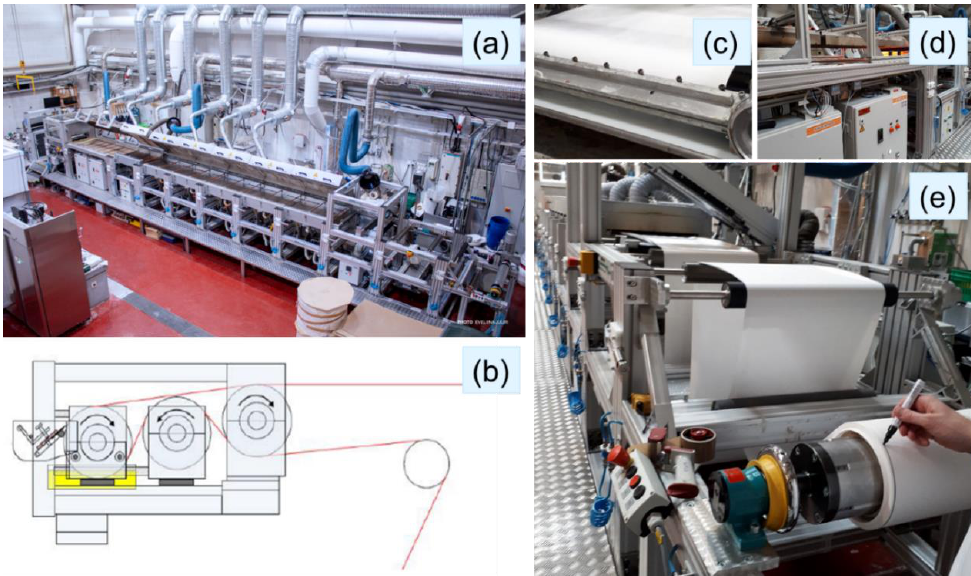
Figure 1. ( a ) VTT’s surface treatment concept pilot line, ( b ) a schematic of the rod coating station, ( c , d ) coating application and drying, and ( e ) coated and dried